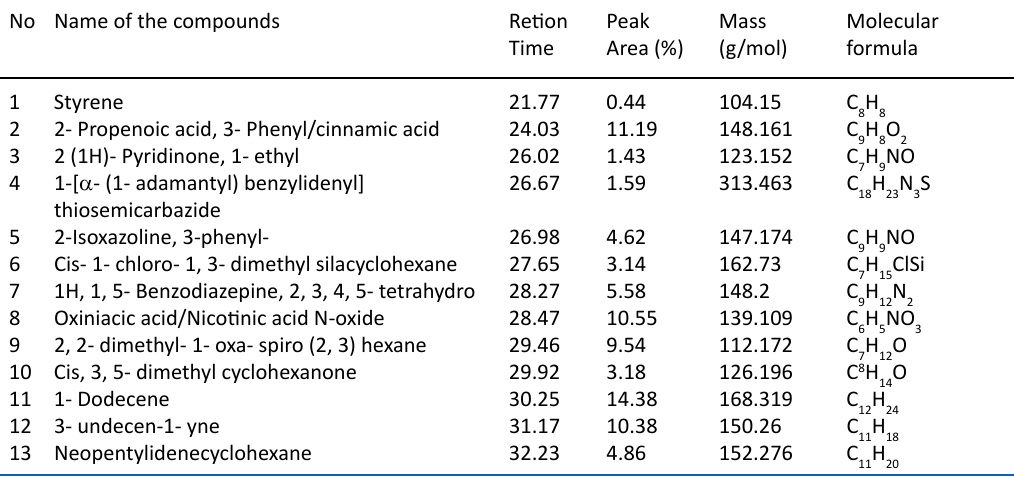
Table 2. Bioactive compounds from M. karstenii No Name of the compounds Retion